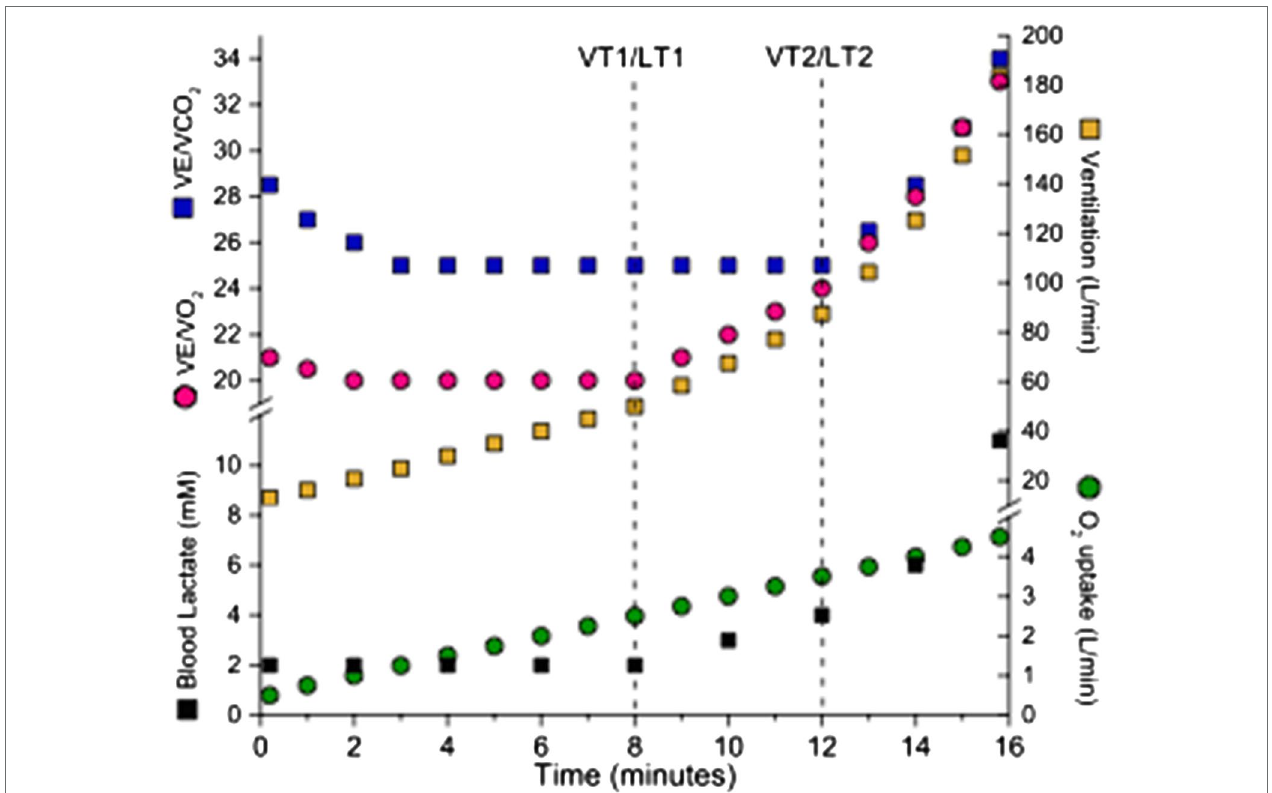
FIGURE 1 | Incremental test for detection of thresholds. Pulmonary measurements and blood lactate concentration allow detection of boundary conditions known as first and second threshold (vertical dashed